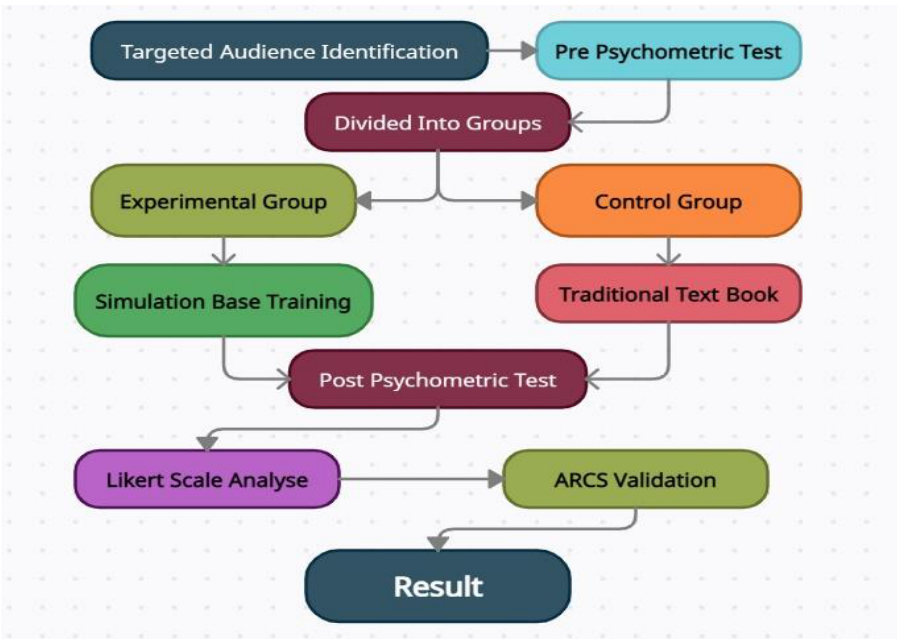
Figure 1. Proposed model integrating VR in education to improve learning and practice for the medical concepts.